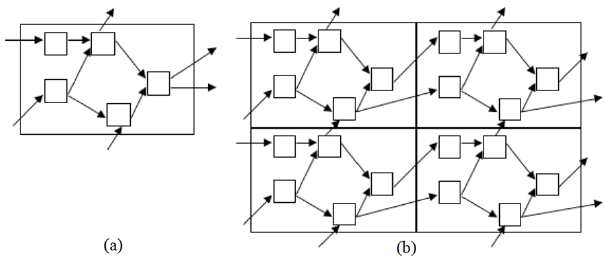
Figure 2. (a) Example of a modular graph with five modules, as- sumed representative of the pointwise equations of a given model; (b) partial view of the replication of the graph in space. Each ele- mentary graph with five modules is associated with one grid point. Source: Nardi et al.